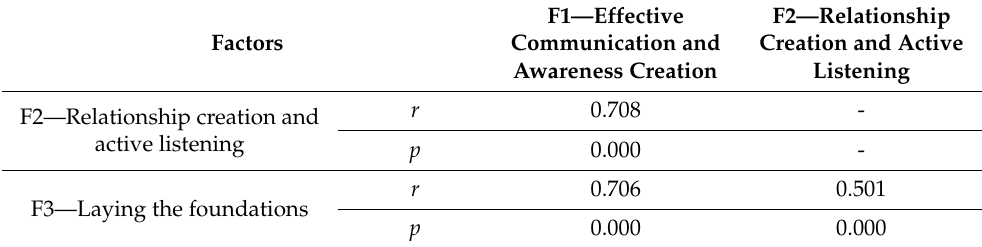
Table 3. Intercorrelations of the CCC3 methodology